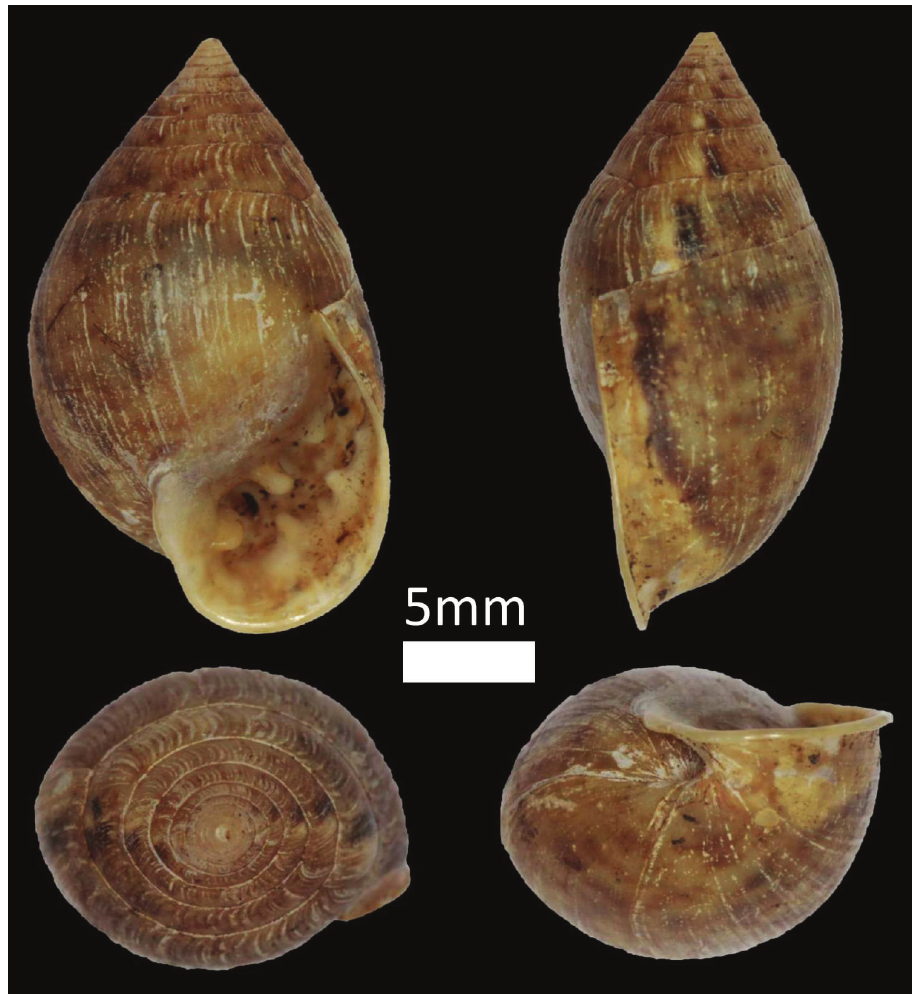
Figure 17. Family Ellobiidae. Pythia chrysostoma (BOR/MOL